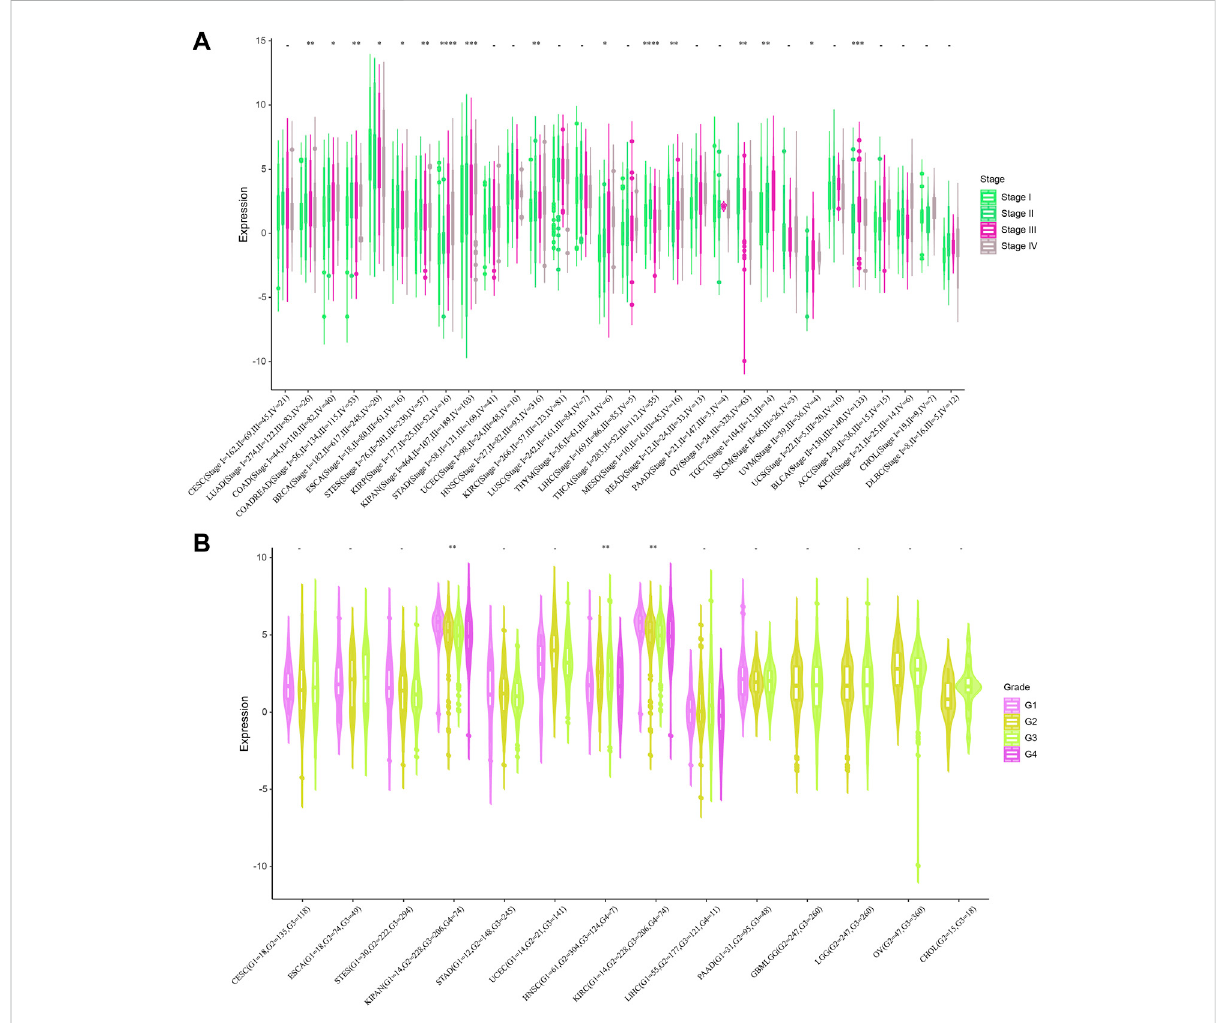
FIGURE 5 Correlation between STC2 Expression and Clinical phenotypes. (A) The relationship between STC2 expression and Stage; (B) The relationship between STC2 expression and Grade. *: p -value < 0.05; **: p -value < 0.01, ***: p -value < 0.001, ****: p -value <